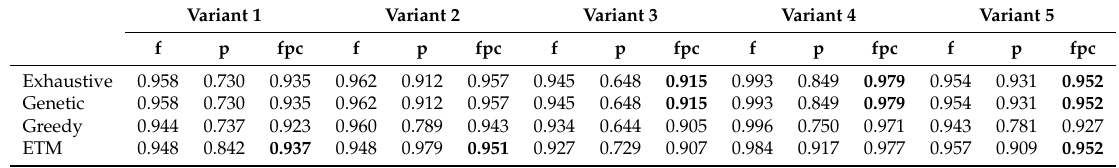
Table 4. Results for CPT 4-A and the event logs corresponding to the five process variants. Variant 1